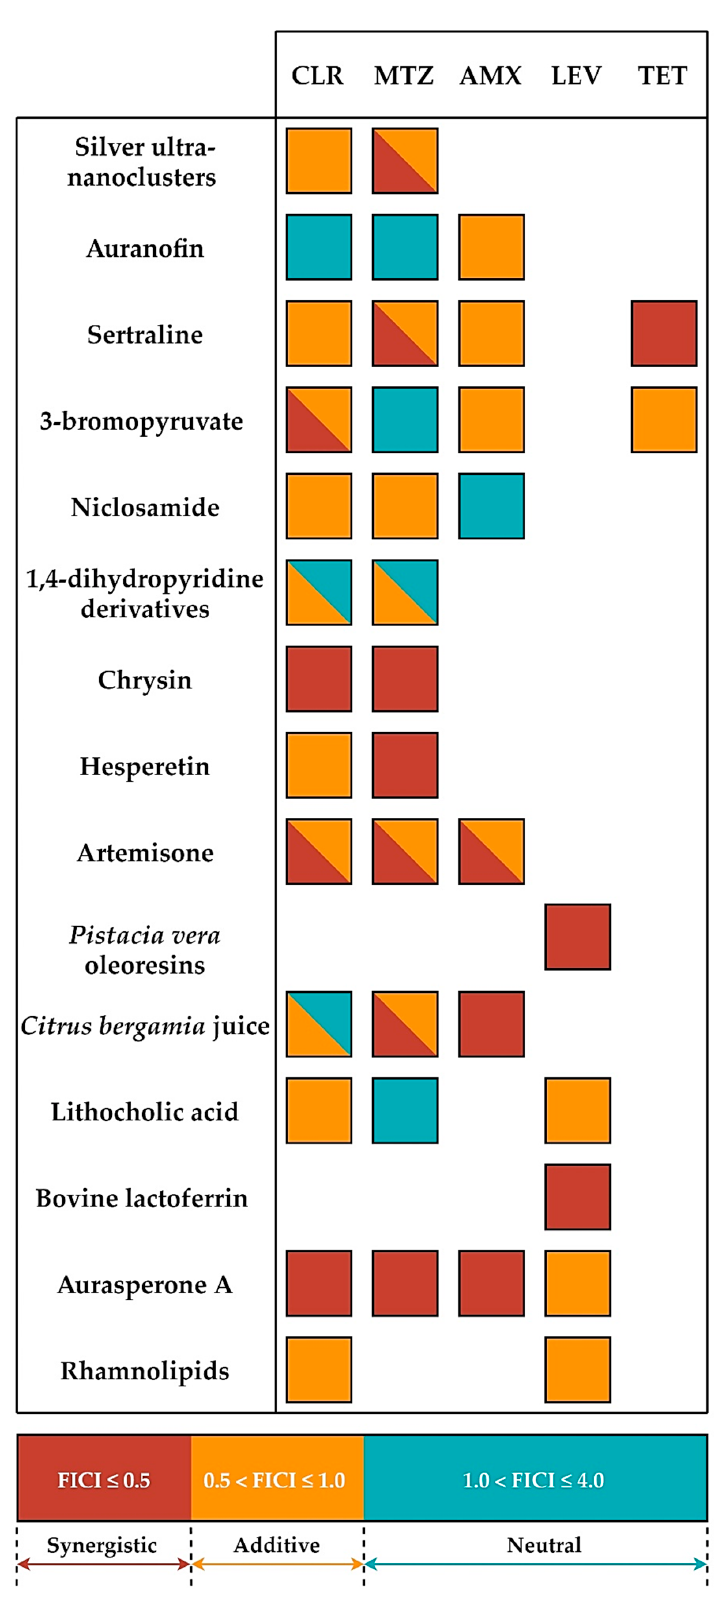
Figure 1. Holistic presentation of interactions between new non-antibiotic compounds and classically used antibiotics against H. pylori .